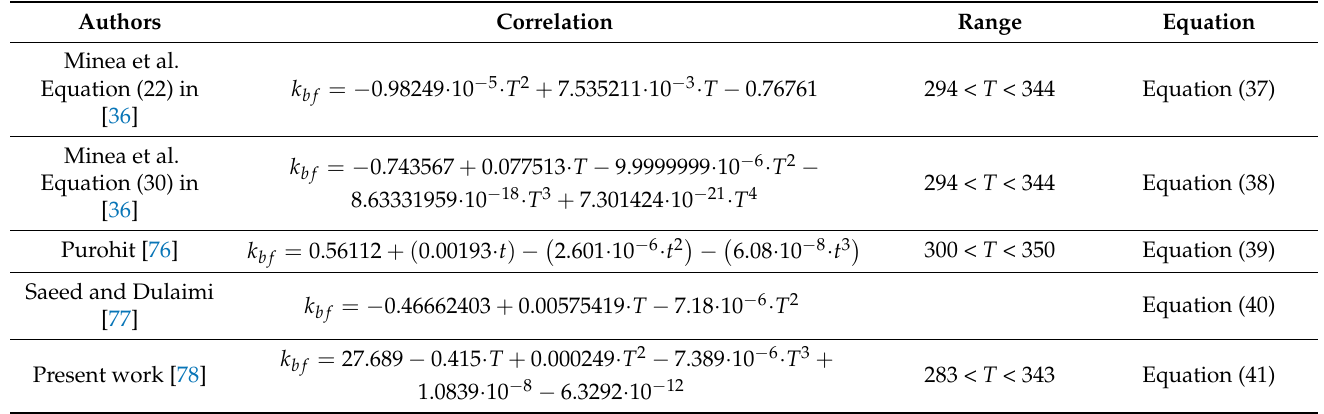
Table 7. Correlations for thermal conductivity of water.